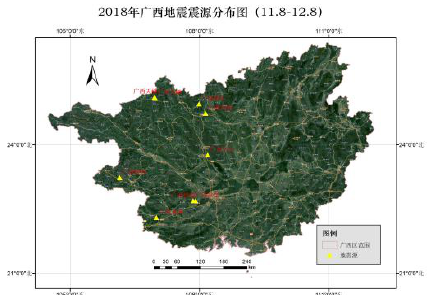
Figure 5. Earthquake distribution location in guangxi region In order to better observe the location of the Seismic source and the magnitude of the Seismic source, different colors are used to display the place names as shown in Figure 6 and scatter point Figure 7. The magnitude of the earthquake is shown by the size of the markers.